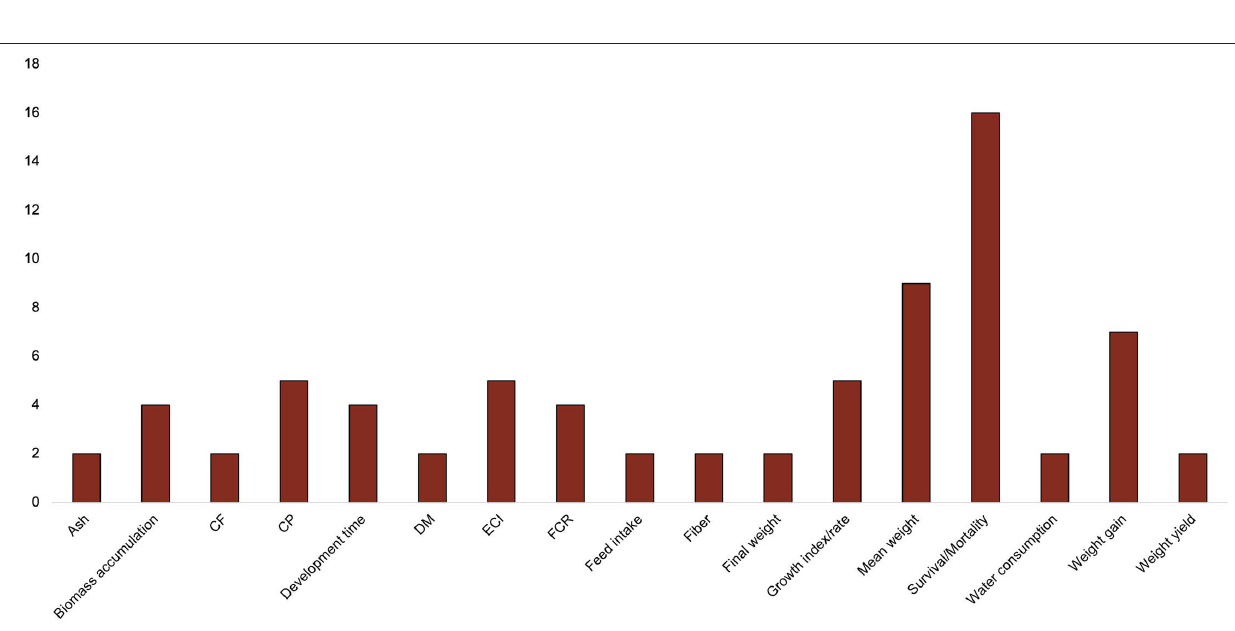
Frontiers in Sustainable Food Systems |